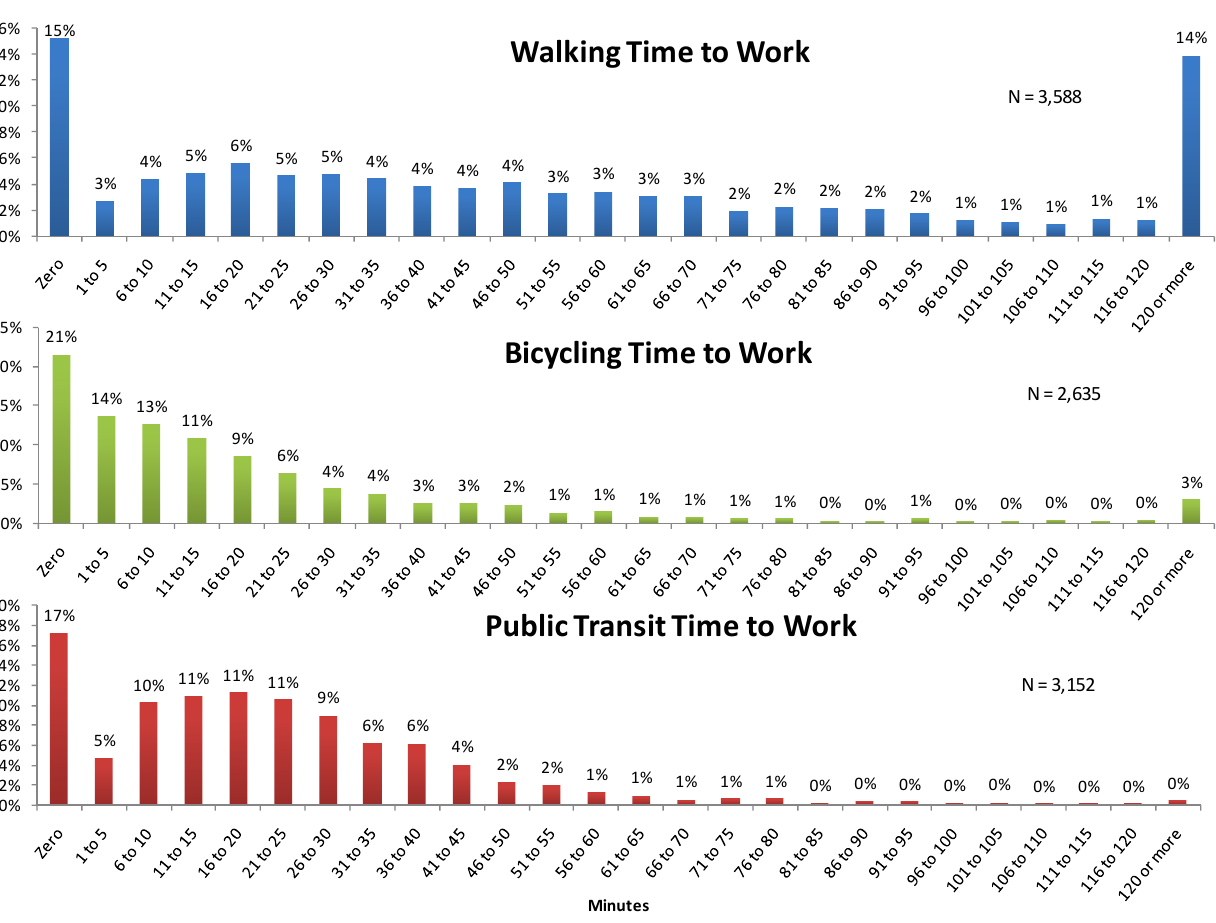
Figure 3. Distribution of Walking, Biking, and Public Transit Time to Work for North American Carsharing Members